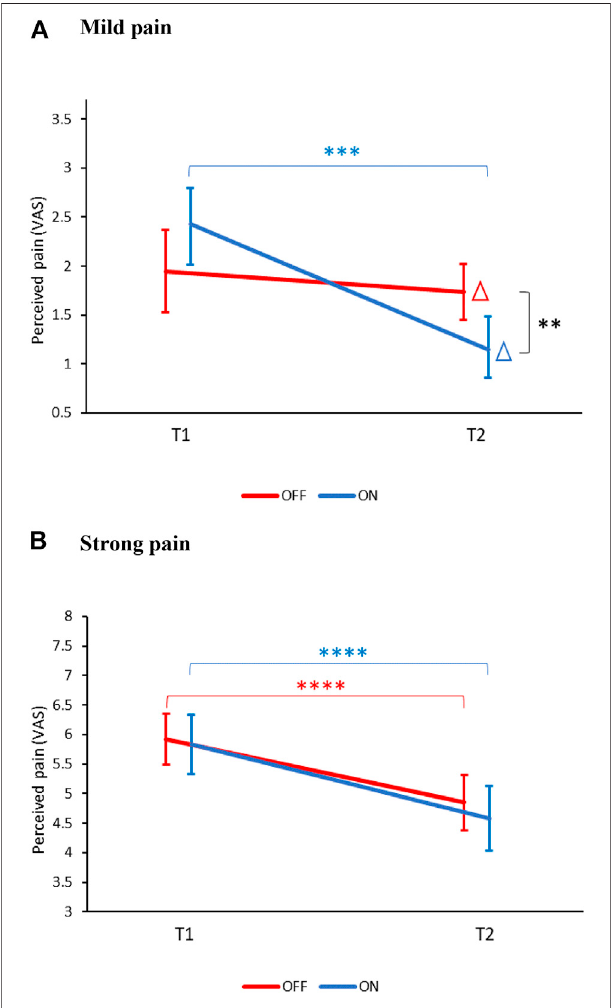
FIGURE 4 | Changes in pain perception between BASELINE (T1) and TOUCH (T2). (A) Mild pain: The change in pain ratings (marked with a Δ ) from T1 to T2 was signi fi cantly different between the ON (blue) and OFF (red) groups (** p < 0.01). Only in the ON group, pain ratings decreased signi fi cantly at T2 compared to T1 (*** p < 0.001). (B) Strong pain: In both the ON and the OFF groups, pain ratings decreased at T2 compared to T1 (*** p < 0.0001). Values denote mean visual-analogue scale (VAS) ratings (0 – 10) ± SEM. T1 — before encountering PARO, T2 — while touching PARO.